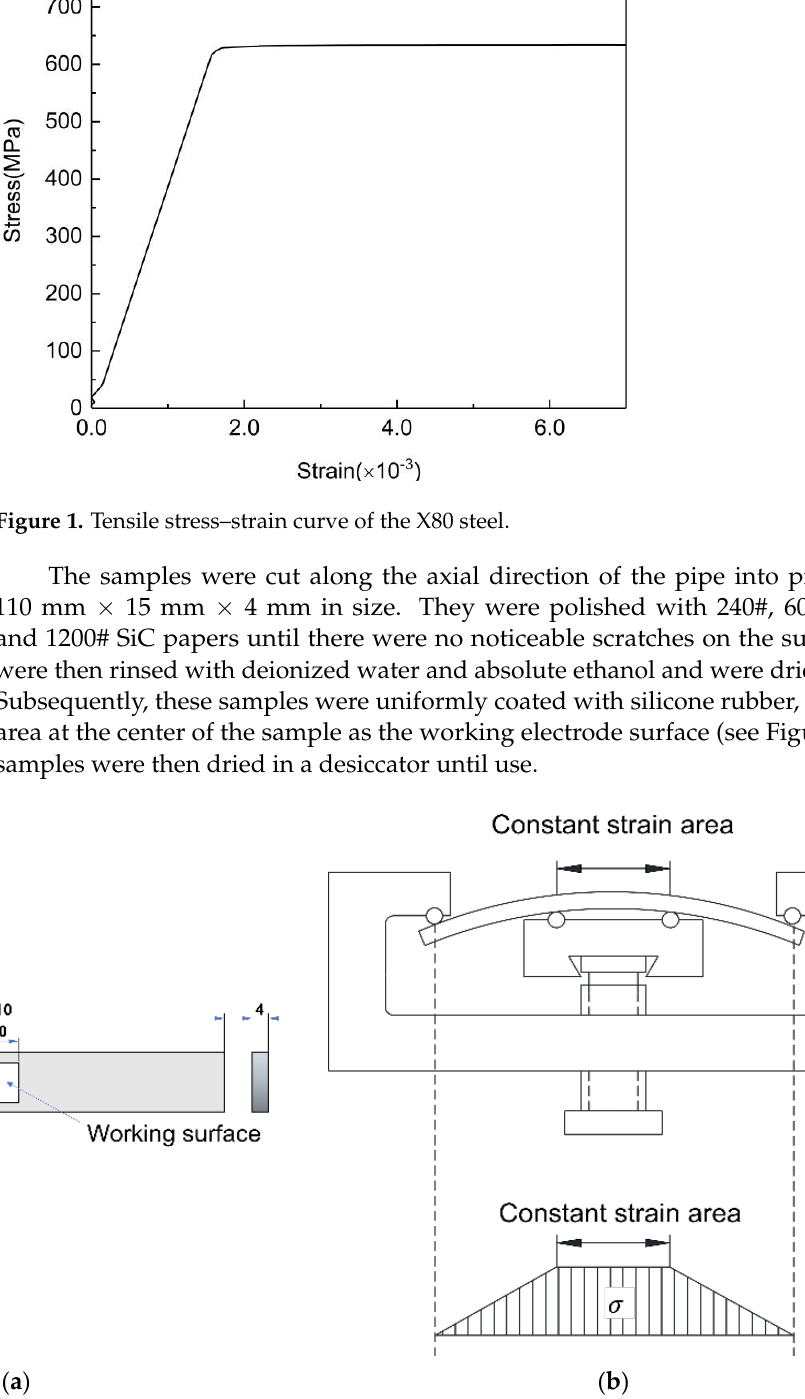
Figure 2. ( a ) The geometry and the size of the X80 steel sample (unit: mm). ( b ) Four-point-bend loading apparatus. Table 2. Composition of NS4 solution (g/L).